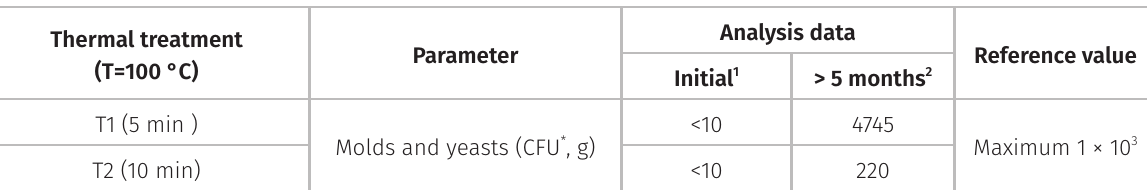
Table VII. Microbiological count in low-calorie grape